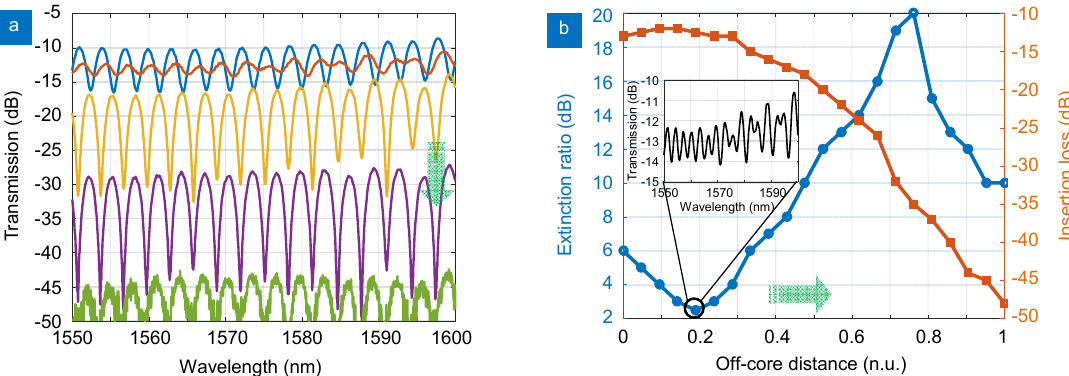
Fig. 5 | Collected optical spectra under different offset distances between SMF and four-mode fiber (a) and the summarized extinction ratio as well as insertion loss variation with offset distance